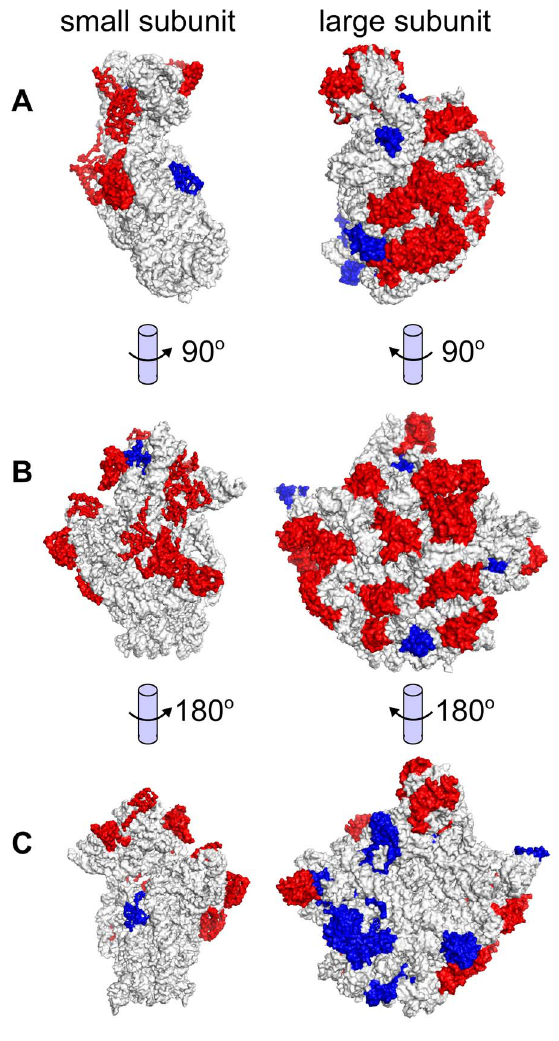
Figure 6. Ribosomal subunit isoelectric points. Structural mappings of the large and small ribosomal subunits, showing protein monomers with predicted low (red) and high (blue) pI. Subunits are oriented according to (A) complex formation, (B) cytoplasmic view of each subunit, and (C) internal view of each subunit. Subunits exposed to the cytoplasm tend to be acidified (red subunits, visible in B), while subunits buried within the ribosome tend to have an alkaline isoelectric point (blue subunits, visible in C). Structural models used were those for Thermus thermophilus (1FKA) [97] and Haloarcula marismortui (1QVG)